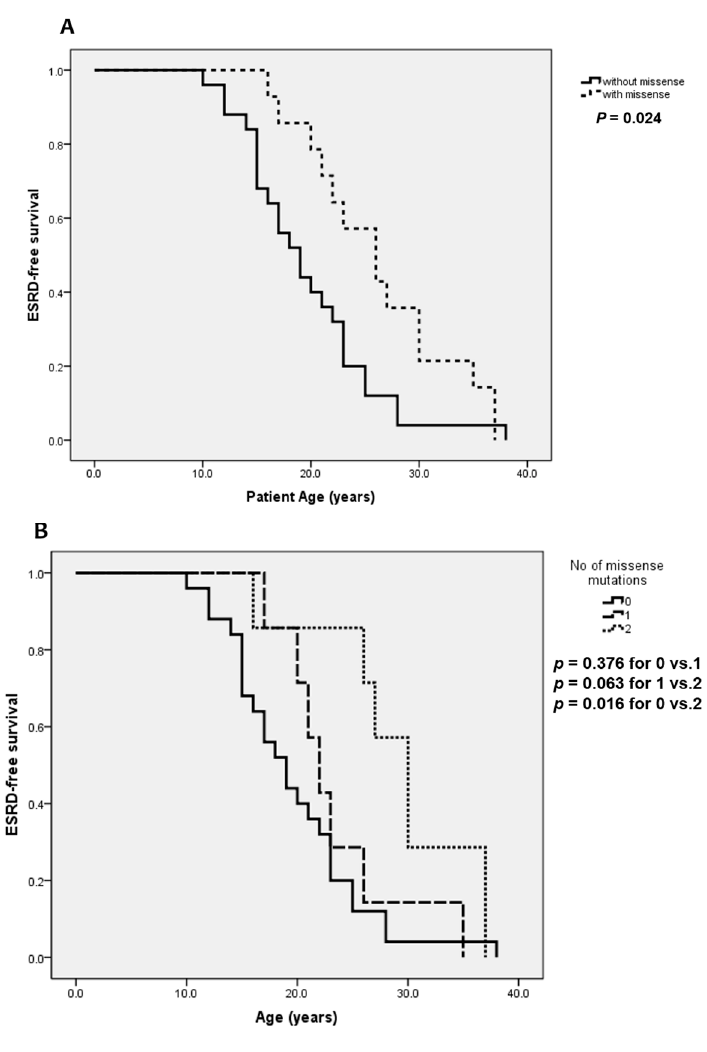
Figure 2. ESRD-free survival of ARAS patients according to ( A ) presence of missense mutation and ( B ) number of missense mutations.